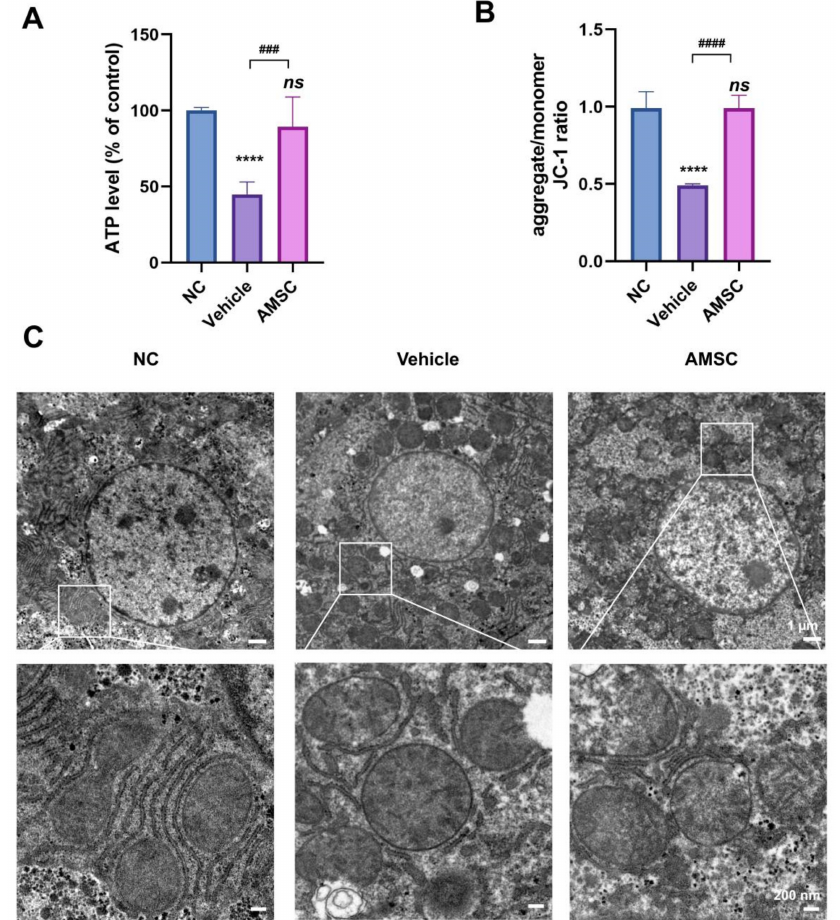
Figure 2. AMSC treatment prevents APAP-induced mitochondrial dysfunction. ( A ) Hepatic ATP levels in each group. Mice were sacrificed after APAP overdosing and AMSC treatment for 6 h. ( B ) JC-1 staining for detecting ∆Ψ m in each group. ( C ) Distinctive mitochondrial morphological changes were detected by electron microscopy in mouse livers treated with APAP and AMSC. Data are expressed as mean ± SD; n = 5; **** p < 0.0001 and ns: no significance vs. NC group; ### p < 0.001 and #### p < 0.0001 vs. vehicle group. NC group: normal control mice; vehicle group: APAP- overdosed mice; AMSC group: AMSC-treated